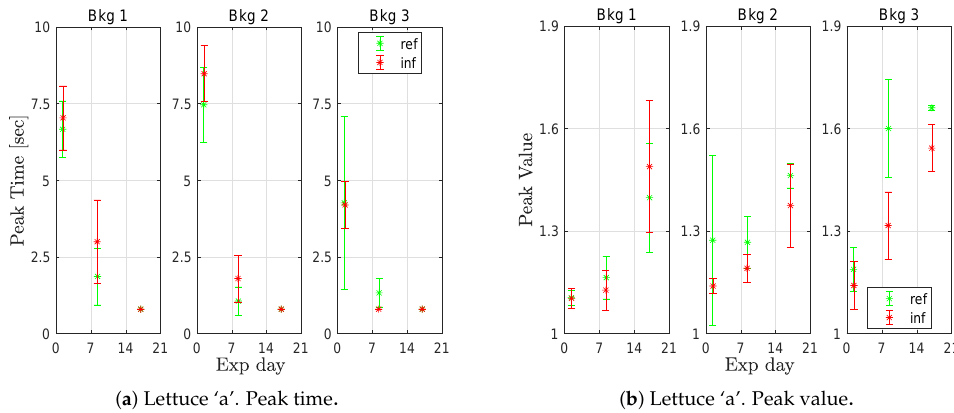
Figure 9. The fluorescence step response peak time ( a ) and peak value ( b ) for lettuce ‘a’ at three different background light levels. The mean value and std for two to five measurements each week and for each group (reference and infected with Pythium ultimum ).